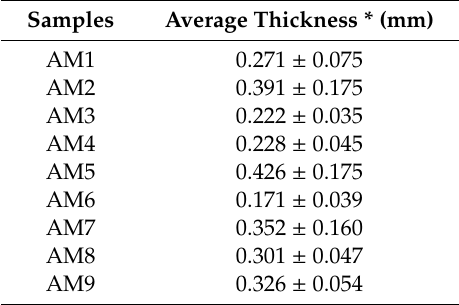
Figure 11. SEM photomicrographs of all hollow fiber membranes: ( a ) 27× and ( b ) 700×. Table 7. Average thickness values of the membranes.